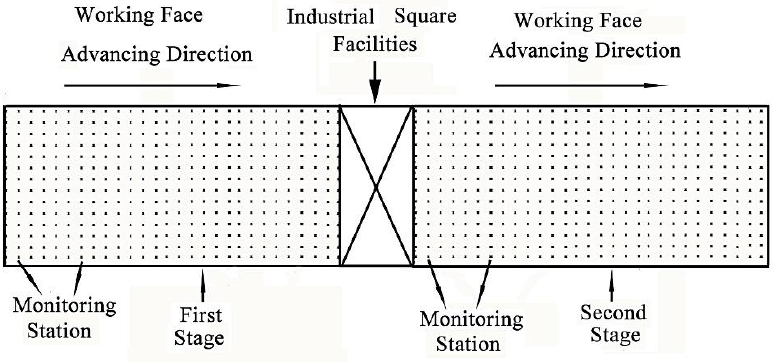
Figure 17. Layout diagram of the monitoring stations.